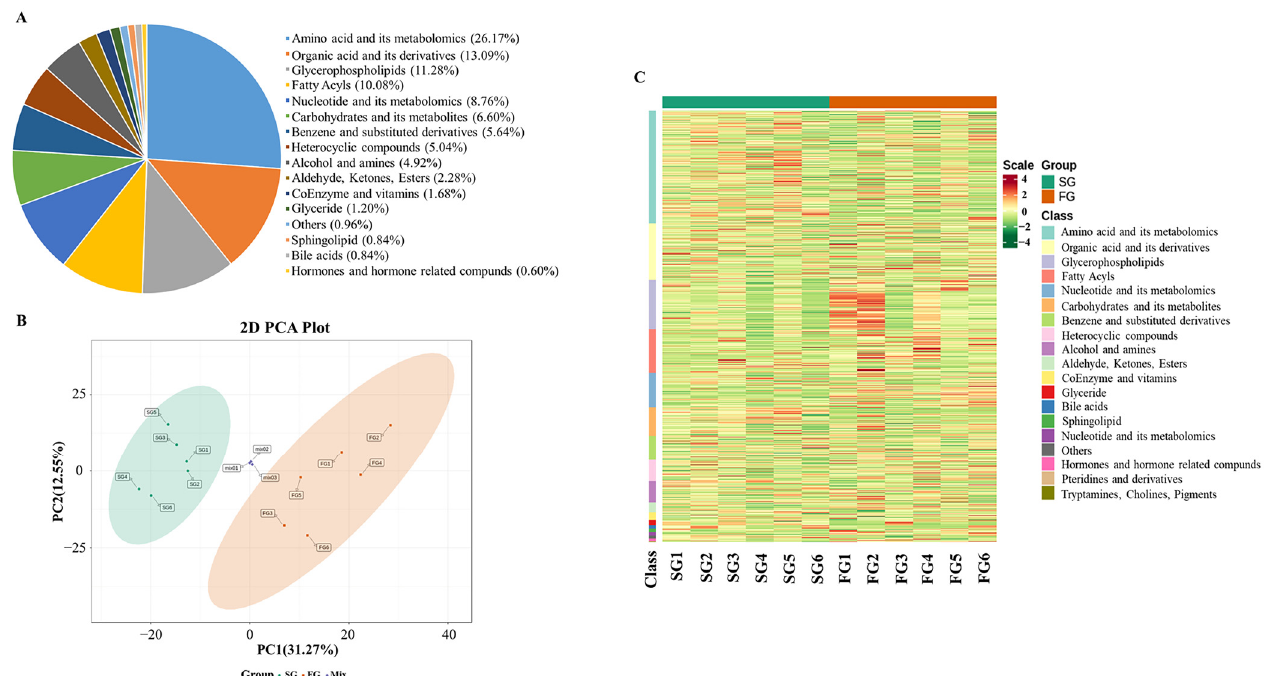
Figure 2. Overall profile of metabolites in slow-growing and fast-growing (SG and FG) duck breast meat. ( A ) The 833 metabolites divided into 16 different categories of meat samples. ( B ) Unsupervised principal component analysis (PCA) of two breeds with six biological replicates. ( C ) Heat map revealing expression pattern of metabolites among SG and FG meat.